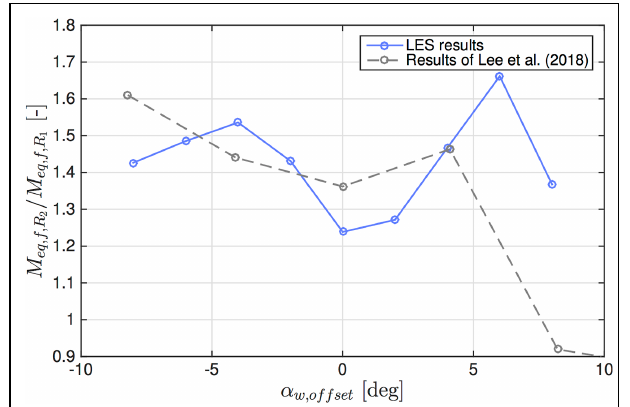
FIGURE 11 | Flapwise equivalent moment of R 2 , normalized by that of R 1 , as a function of the incoming wind direction. The wind direction is expressed as the offset with respect to 270 ° . The results of Lee et al. (2018) are also reported; the ratios are computed based on the absolute values available in Lee et al.